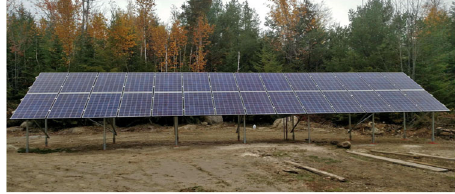
Fig. 12 Examined PV modules placed outdoor after the PID test is completed. The PV system consists of 28 modules distributed among two strings, each string comprising 14